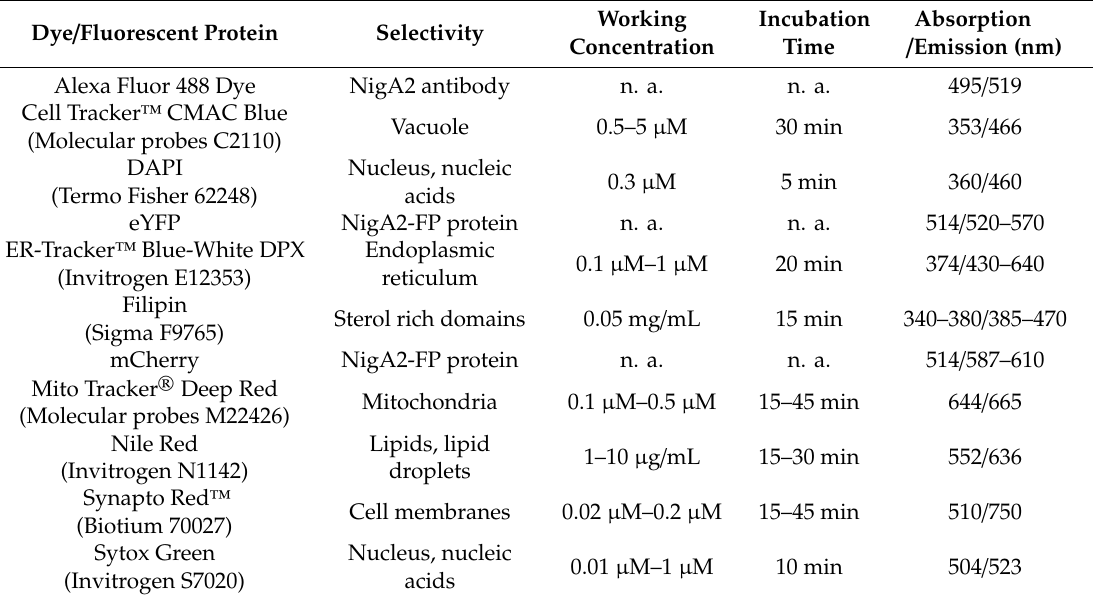
Table 2. Properties of applied dyes and fluorescent